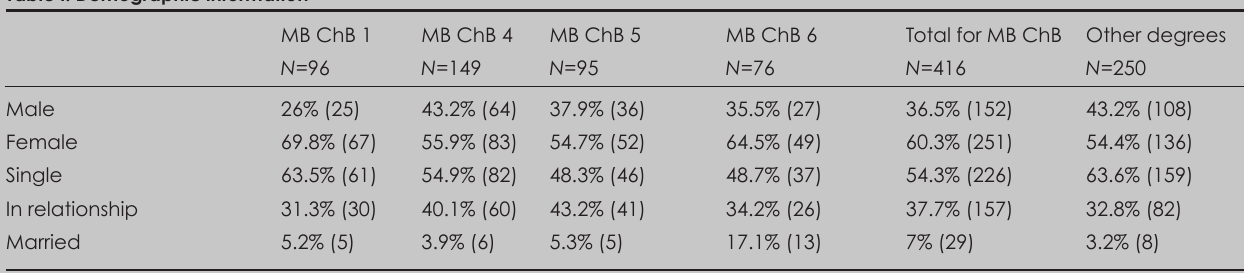
Table I. Demographic